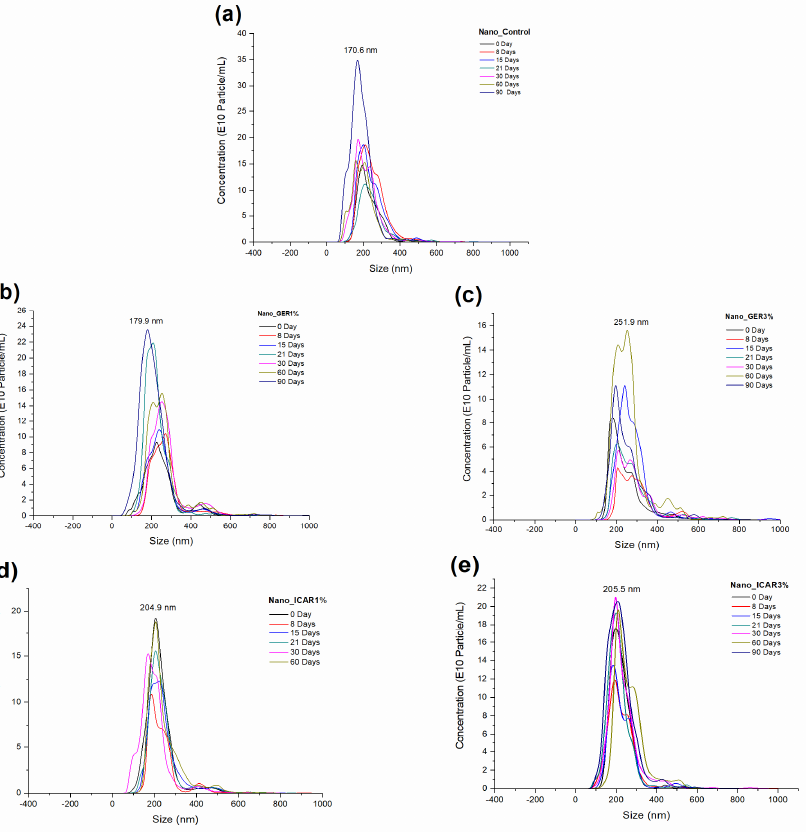
Figure 4. Particle size distribution as a function of concentration and time (0, 8, 15, 21, 30, 60, and 90 days) of the formulations ( a ) Nano_Control, ( b ) Nano_GER1%, ( c ) Nano_GER3%, ( d ) Nano_ICAR1%, and ( e ) Nano_ICAR3% using Nanoparticle Tracking Analysis The results show that the nanocapsules present lower diameters than those obtained using DLS. According to Filipe et al. [33], this difference in values can be explained by the size distribution in DLS based on mass distribution, unlike the values obtained by NTA, which are based on numerical distribution. Maruyama et al. [34] observed a slight differ- ence in the size of nanocapsules when developing polymeric nanocapsules containing two different nanocapsules of herbicides. The difference in values obtained between these techniques may be associated with the analysis process by NTA, in which the samples undergo a greater dilution than that used in the DLS; consequently, this dilution can cause the rupture of aggregates resulting in average values of particle distribution slightly smaller than those obtained by the DLS technique [35]. 2.2. Differential Scanning Calorimetry (DSC) The DSC profile of the PCL polymer shows a narrow (Figure 5) endothermic peak at 59 °C, representing the polymer’s melting point and, thus, supporting its crystallinity. Be- cause it is a thermoplastic polymer, PCL has a low melting index, starting at approxi- mately 50–55 °C (43). The Nano_Control formulation shows an endothermic peak at ap- proximately 48 °C, corresponding to the polymer melting temperature; a second peak